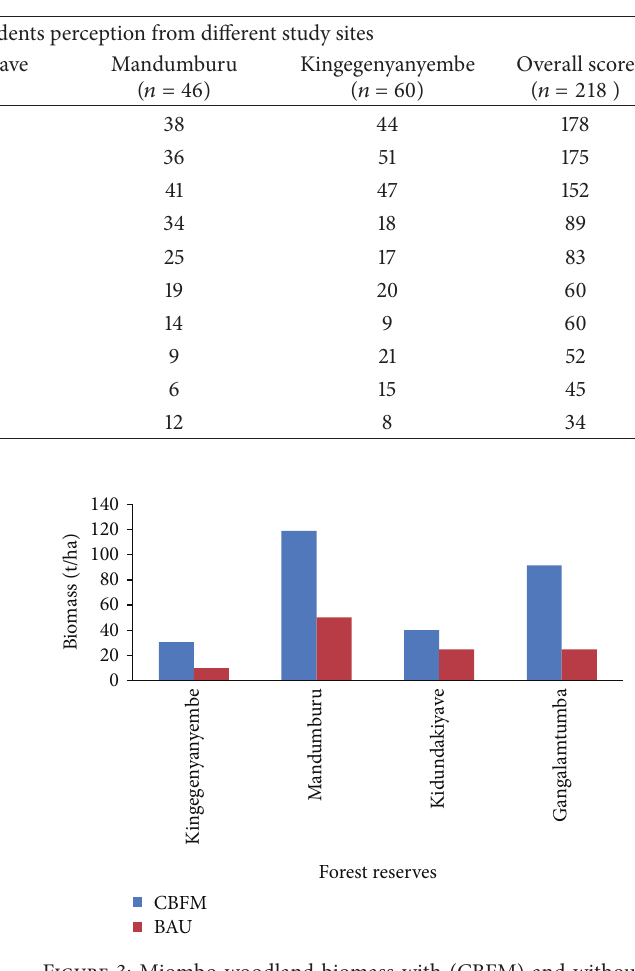
Figure 3: Miombo woodland biomass with (CBFM) and without